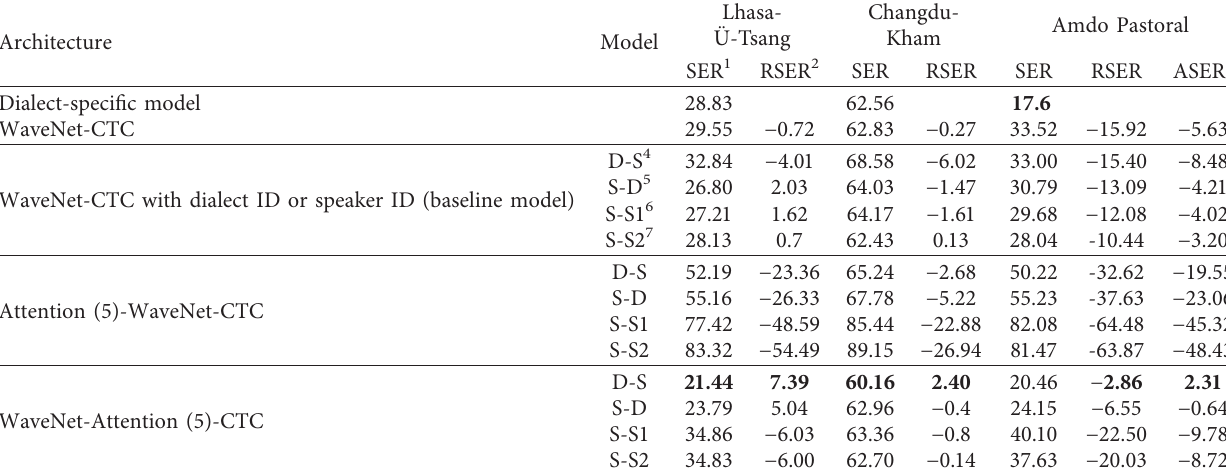
Table 2: Syllable error rate (%) of two-task models on speech content recognition. Architecture